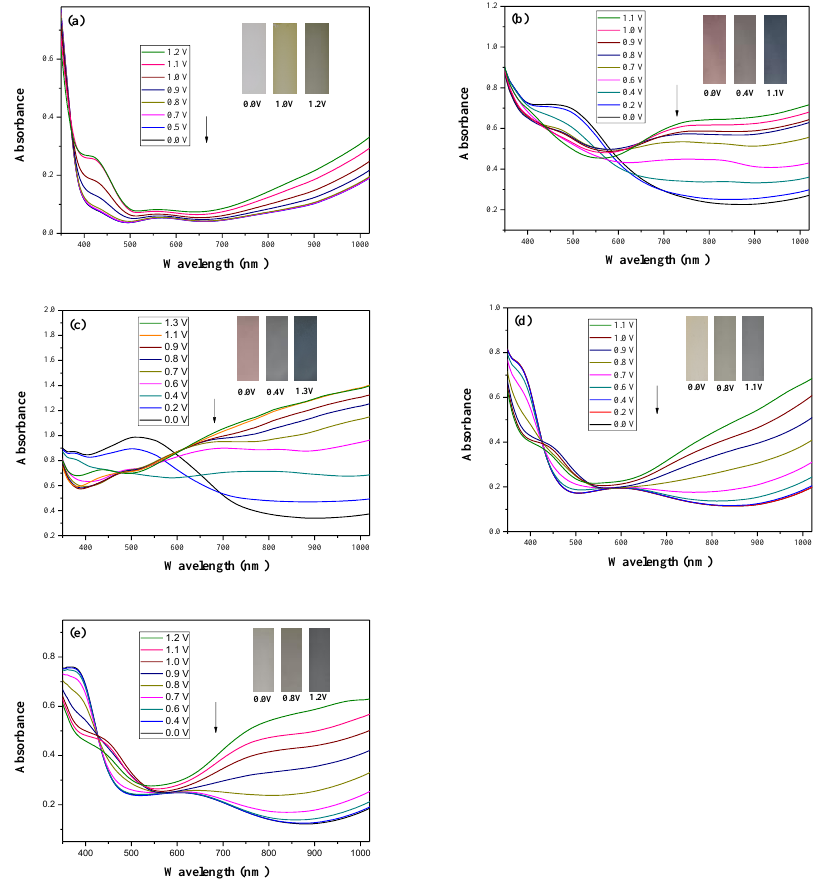
Figure 4. CV curves of the P(DiCP- co -CPDTK) films at different scan rates between 10 and 200 mV s − 1 in 0.2 M LiClO 4 /ACN/DCM solution. Scan rate dependence of the anodic and cathodic peak current densities for P(DiCP- co -CPDTK) films (inset).